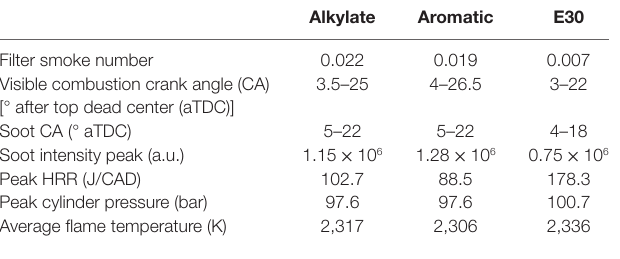
TaBle 4 | Summary of findings from endoscope imaging, heat release rate (HRR), and cylinder pressure for three fuels at 25% exhaust gas recirculating, λ =